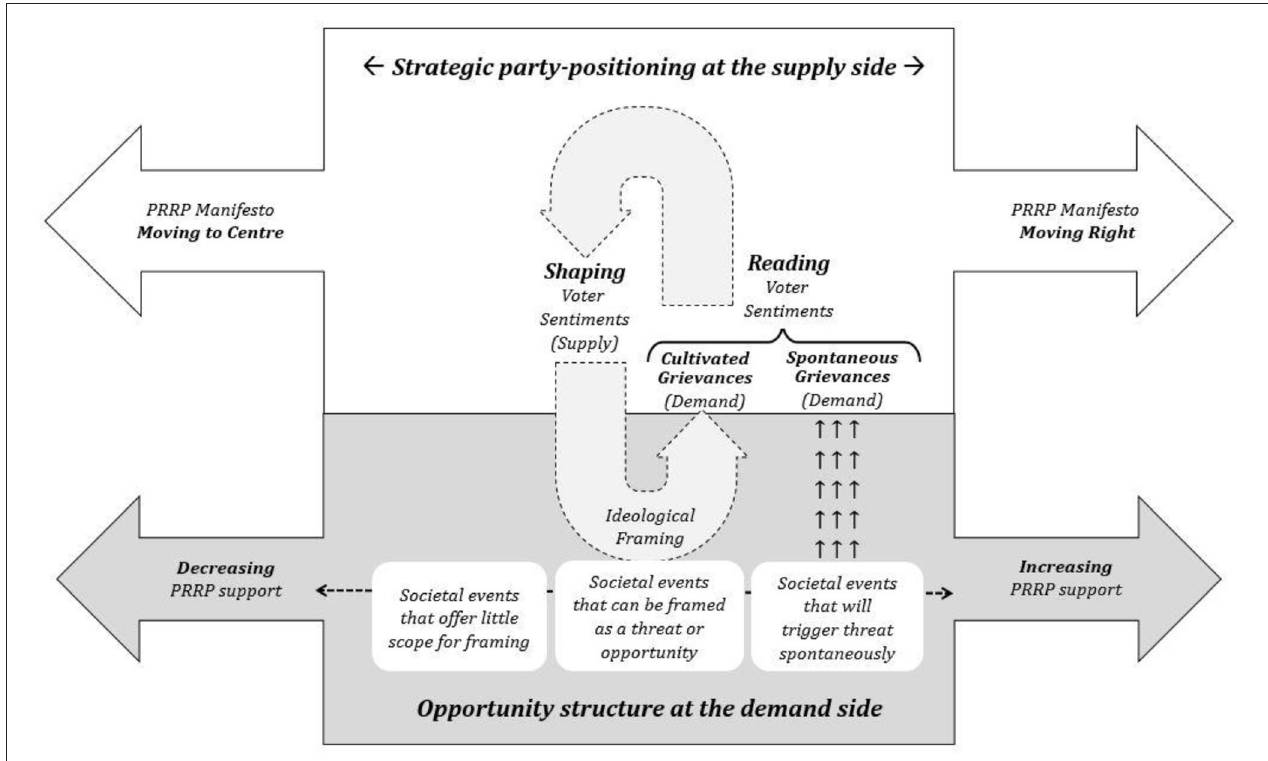
FIGURE 1 | An integrative model of PRRP support: Capturing the interplay between supply (i.e., how PRRPs and their leaders position themselves vis-à-vis the electorate) and demand (i.e., public interest in